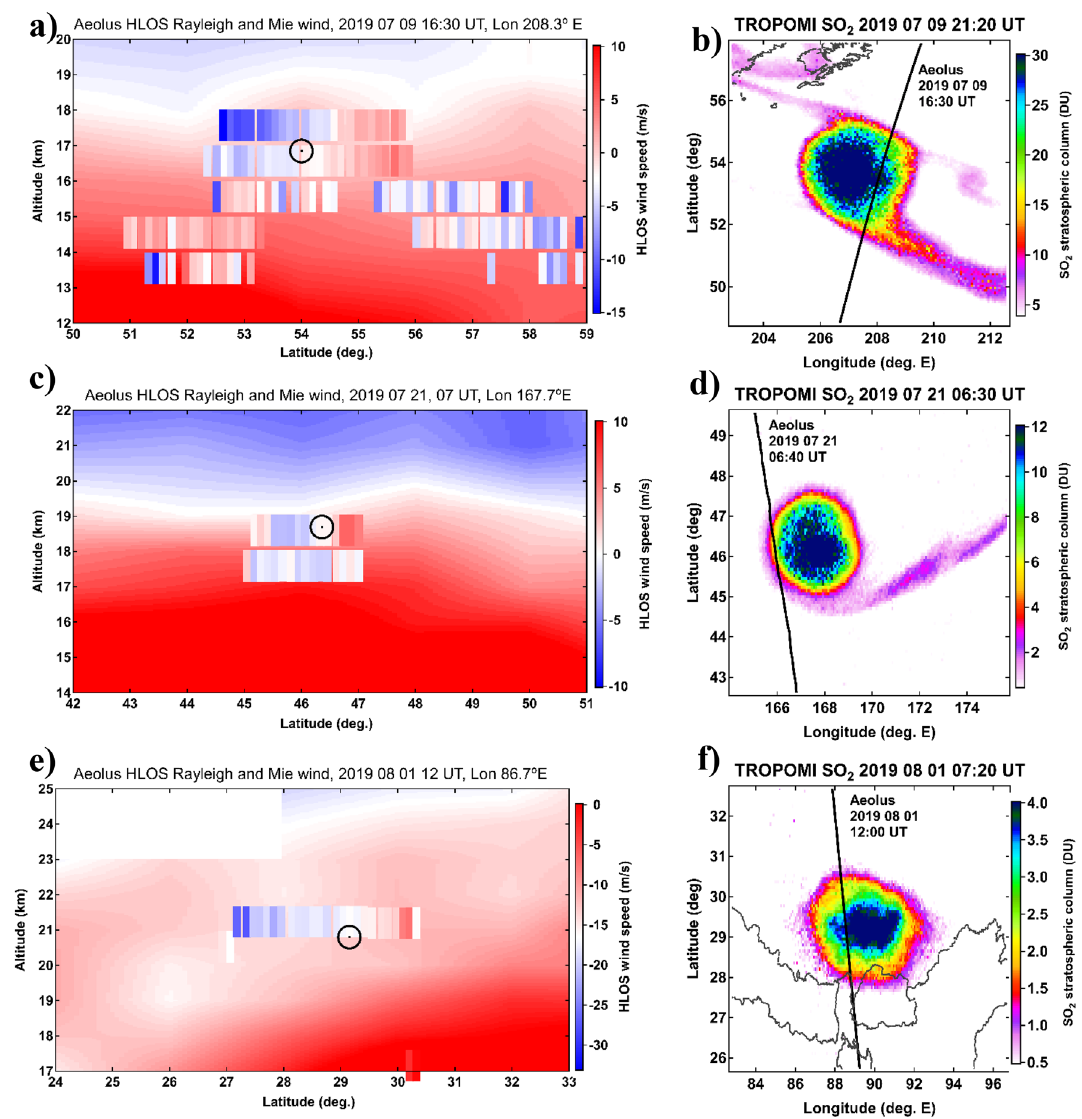
Figure 3. Observations of the secondary (top row) and primary (middle and bottom rows) VVP structures by Aeolus satellite Doppler wind lidar. (left column, a,c,e ) Selected latitude-altitude sections of HLOS (quasi- zonal) wind velocity measured inside the rotating aerosol plume using Mie channel (vertically-elongated pixels) and background wind flow from Rayleigh channel (underlay) obtained by averaging all Aeolus Rayleigh profiles within a 3-d/30° longitude window (around 16 profiles per 1 degree latitude). The black circle marks the latitude-altitude location of the aerosol plume from CALIOP/OMPS-LP tracking. (Right column, b,d,f ) corresponding maps of the confined SO2 plume from TROPOMI measurements and Aeolus orbit (black curve) with indication of date/time. The white blanked out area in panel e is due to ALADIN tropical range bin setting (see